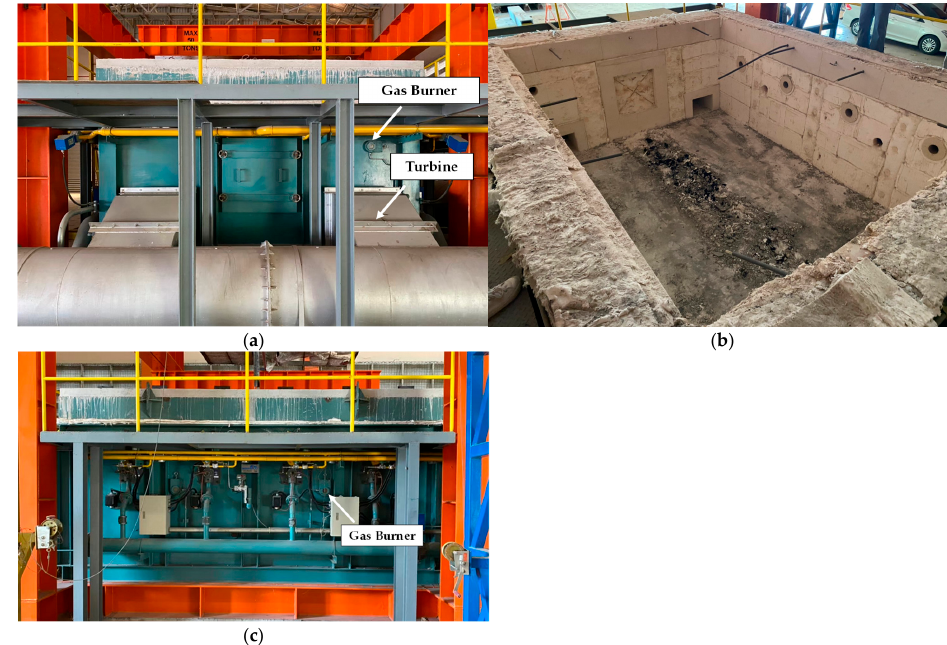
Figure 4. Fire furnace (unit: millimeter); ( a ) front view; ( b ) top view; ( c ) side view.